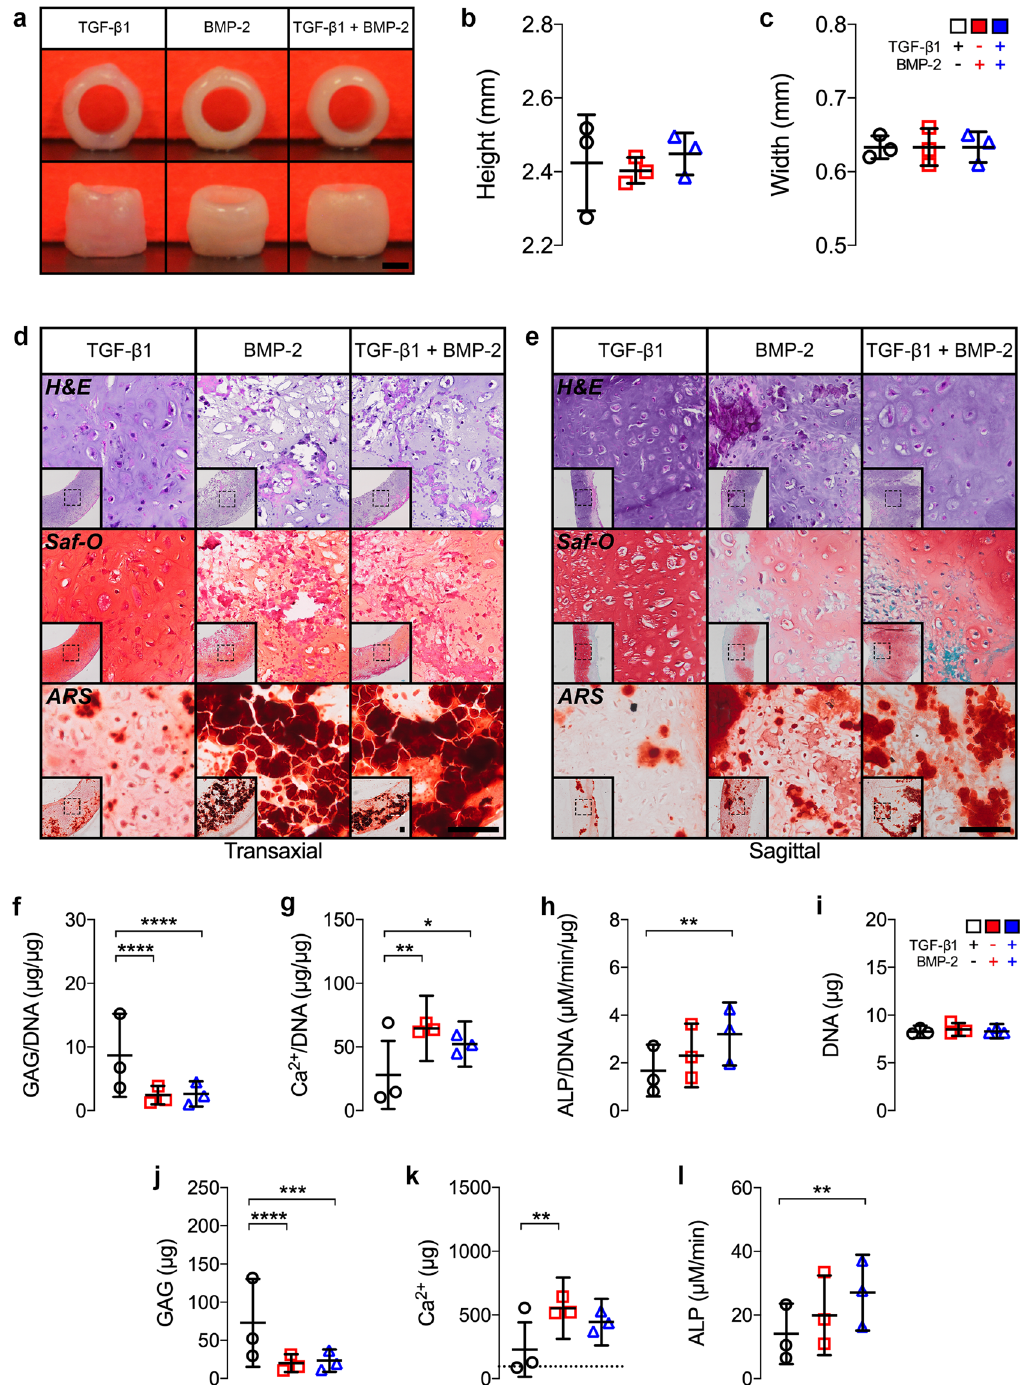
Fig. 3 In vitro macroscopic, biochemical, and histological evaluation of engineered hMSC condensate tube maturation. a Representative gross macroscopic images of hMSC tubes containing TGF- β 1-loaded, BMP-2-loaded, or TGF- β 1 + BMP-2-loaded microparticles at week 5. Scale bar, 1 mm. b , c Quanti fi cation of hMSC tube wall width and height ( n = 3 biologically independent samples per group; black circles = TGF- β 1; red squares = BMP-2; blue triangles = TGF- β 1 + BMP-2). d , e Representative histological Hematoxylin & Eosin (H&E), Safranin-O/Fast-green (Saf-O), and Alizarin Red S (ARS) staining of transaxial and sagittal hMSC tube sections. Scale bars, 100 μ m (dotted squares in insets show region of interest in high magni fi cation image). Quanti fi cation of f GAG/DNA content, g Ca 2 + /DNA content, h ALP activity/DNA, i DNA content, j GAG content, k Ca 2 + content; dashed line represents the amount of Ca 2 + initially contributed by mineral-coated hydroxyapatite microparticles assuming 100% incorporation, and l ALP activity ( n = 3; derived from three hMSC donors (average of averages) each with 3 (TGF- β 1; BMP-2) or 4 (TGF- β 1 + BMP-2) biologically independent samples; * p < 0.05, ** p < 0.01, *** p < 0.001, **** p < 0.0001; black circles = TGF- β 1; red squares = BMP-2; blue triangles = TGF- β 1 + BMP-2). Individual data points are shown with mean ± SD. Analyzed by one-way or two-way ANOVA with Tukey ’ s post hoc test ( p < 0.05 or lower considered signi fi cant).